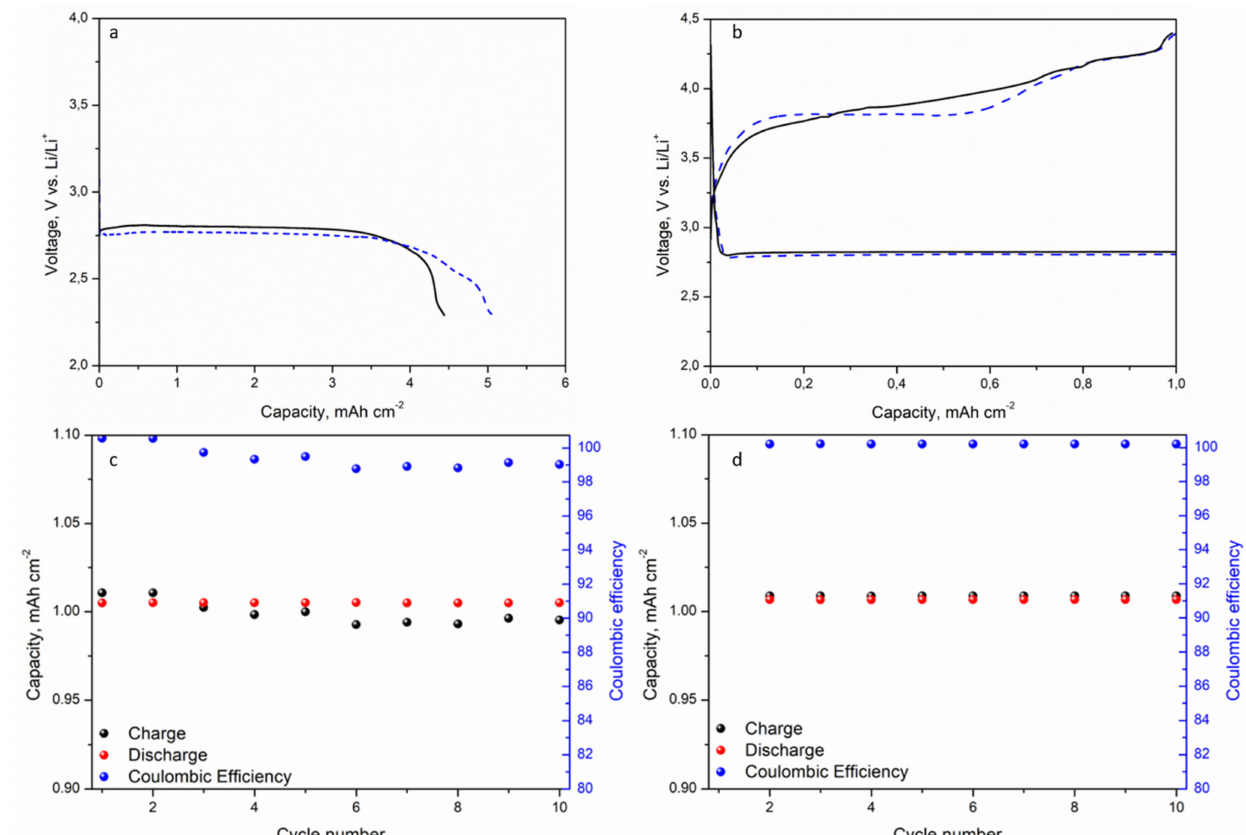
Figure 6. Full discharge profile of the STD cell (solid black line) and 5 wt% NS CGPE cell (dotted red line) ( a ). The 2nd cycle profile of the STD cell (solid black line) and 5 wt% NS CGPE cell (dotted red line) ( b ). Discharge/charge capacities and Coulombic efficiency vs. cycle number of the STD cell ( c ) and 5 wt% NS CGPE cell ( d